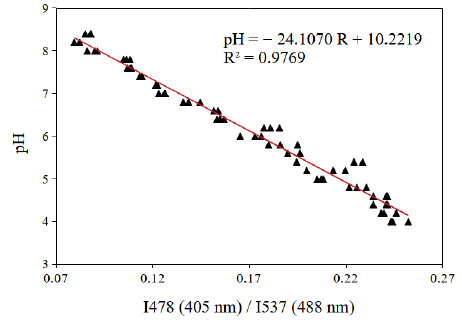
Figure 9. Calibration curve obtained from the best combination of the two lasers (405 nm and 488 nm) for BCECF. The emission wavelength was fixed at 478 nm for the 405 nm laser and at 537 nm for the 488 nm laser (data set in